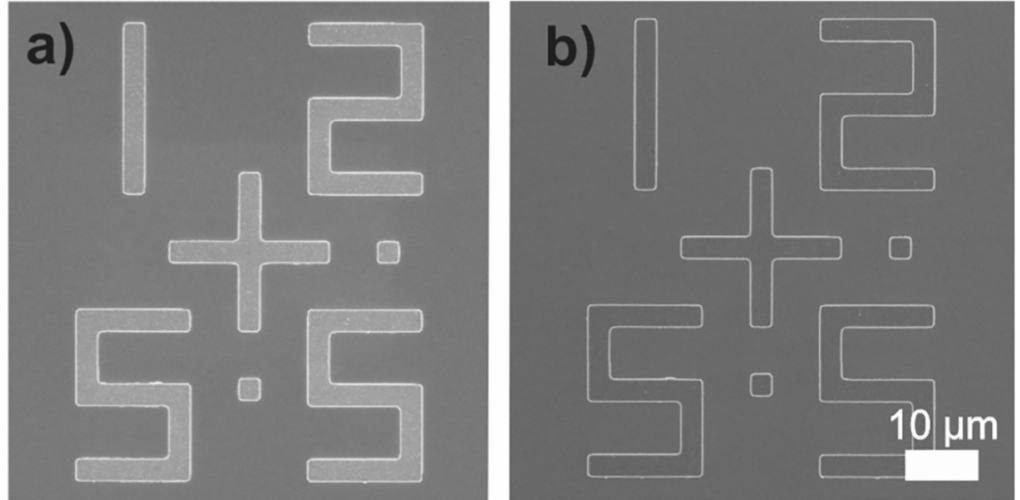
Figure 10. Alignment marks in OIR. SEM images at 5 keV showing Al alignment marks on silicon substrates, ( a ) before and ( b ) after condensing 80-nm-thin nonane ice film. Reprinted with permission from [96]. Copyright 2018,